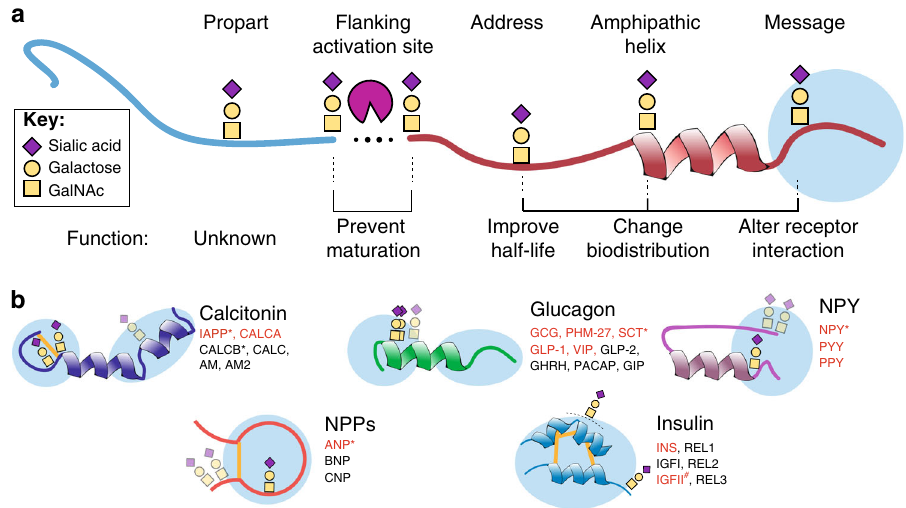
Fig. 3 Topology of O-glycosites in peptide hormones and their predicted functions. a Representation of a generic peptide hormone with indications of potential functional impact of glycosylation sites. b Illustrations of glycopeptide hormone families with message-associated O-glycosites conserved or semi-conserved among the paralogous family members. The message parts of the peptide hormones are indicated by light blue circles. Glycans have been identi fi ed in conserved positions in family members in red. Faded glycosites are not shared within paralogous family members. (*) Denotes peptide hormones containing non-conserved glycosites. (#) The site over the dotted line in the insulin family is covered by ambiguously assigned glycosite(s) in the C-terminal part of IGFII. Full sequence alignments of the fi ve presented glycopeptide hormone families are shown in Supplementary Fig. 3. Please see Supplementary Data 1 for peptide hormone abbreviations.